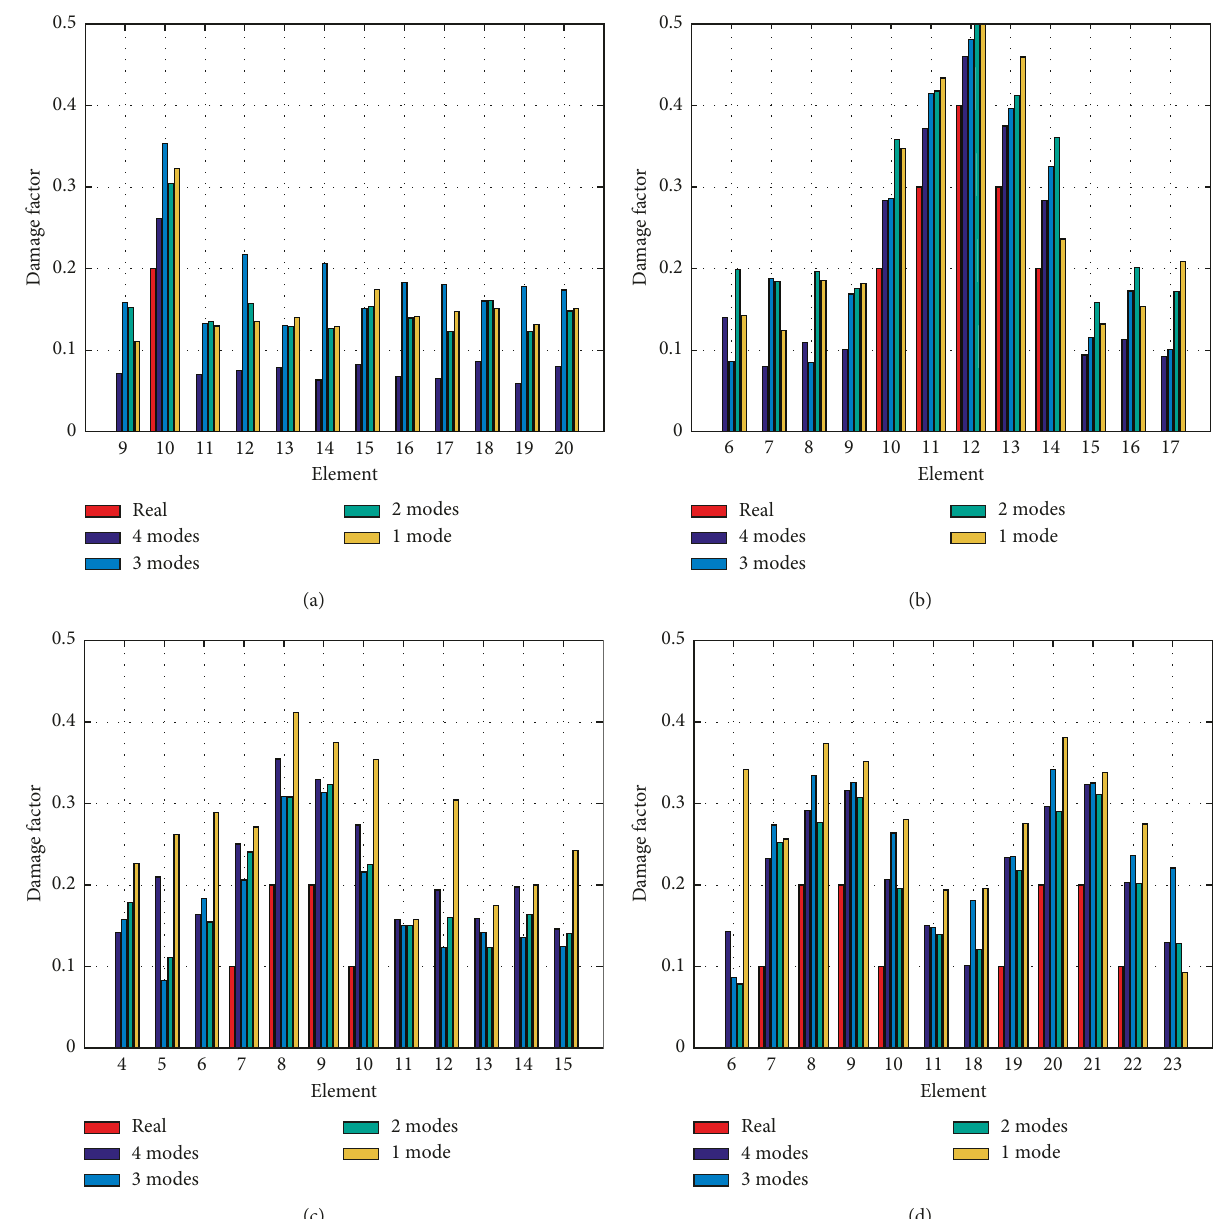
Figure 13: Frame example: damage prediction of the MACFLEX criterion for the four damage scenarios (no noise). Again, the results using the individual MACFLEX criterion are not good, even with four known eigenmodes, let alone cases with less known eigenmodes (1 to 3). (a) Scenario 1, (b) scenario 2, (c) scenario 3, and (d) scenario